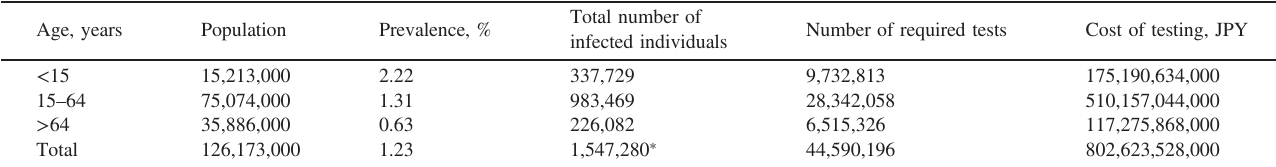
Table 1. Estimated prevalence, total number of infected individuals, number of required tests, and cost of testing until the state of emergency was lifted for each prefecture, strati fi ed by age group